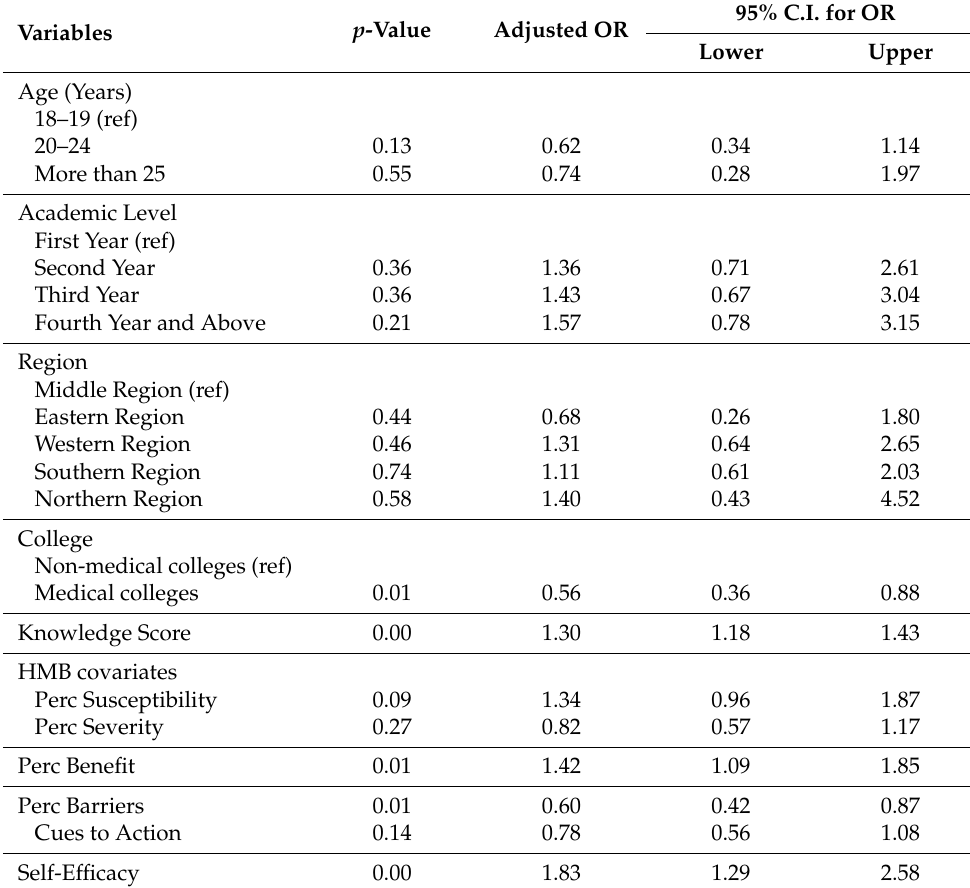
Table 5. Multivariate logistic regression analysis of independent predictors of the BSE intention. Variables p